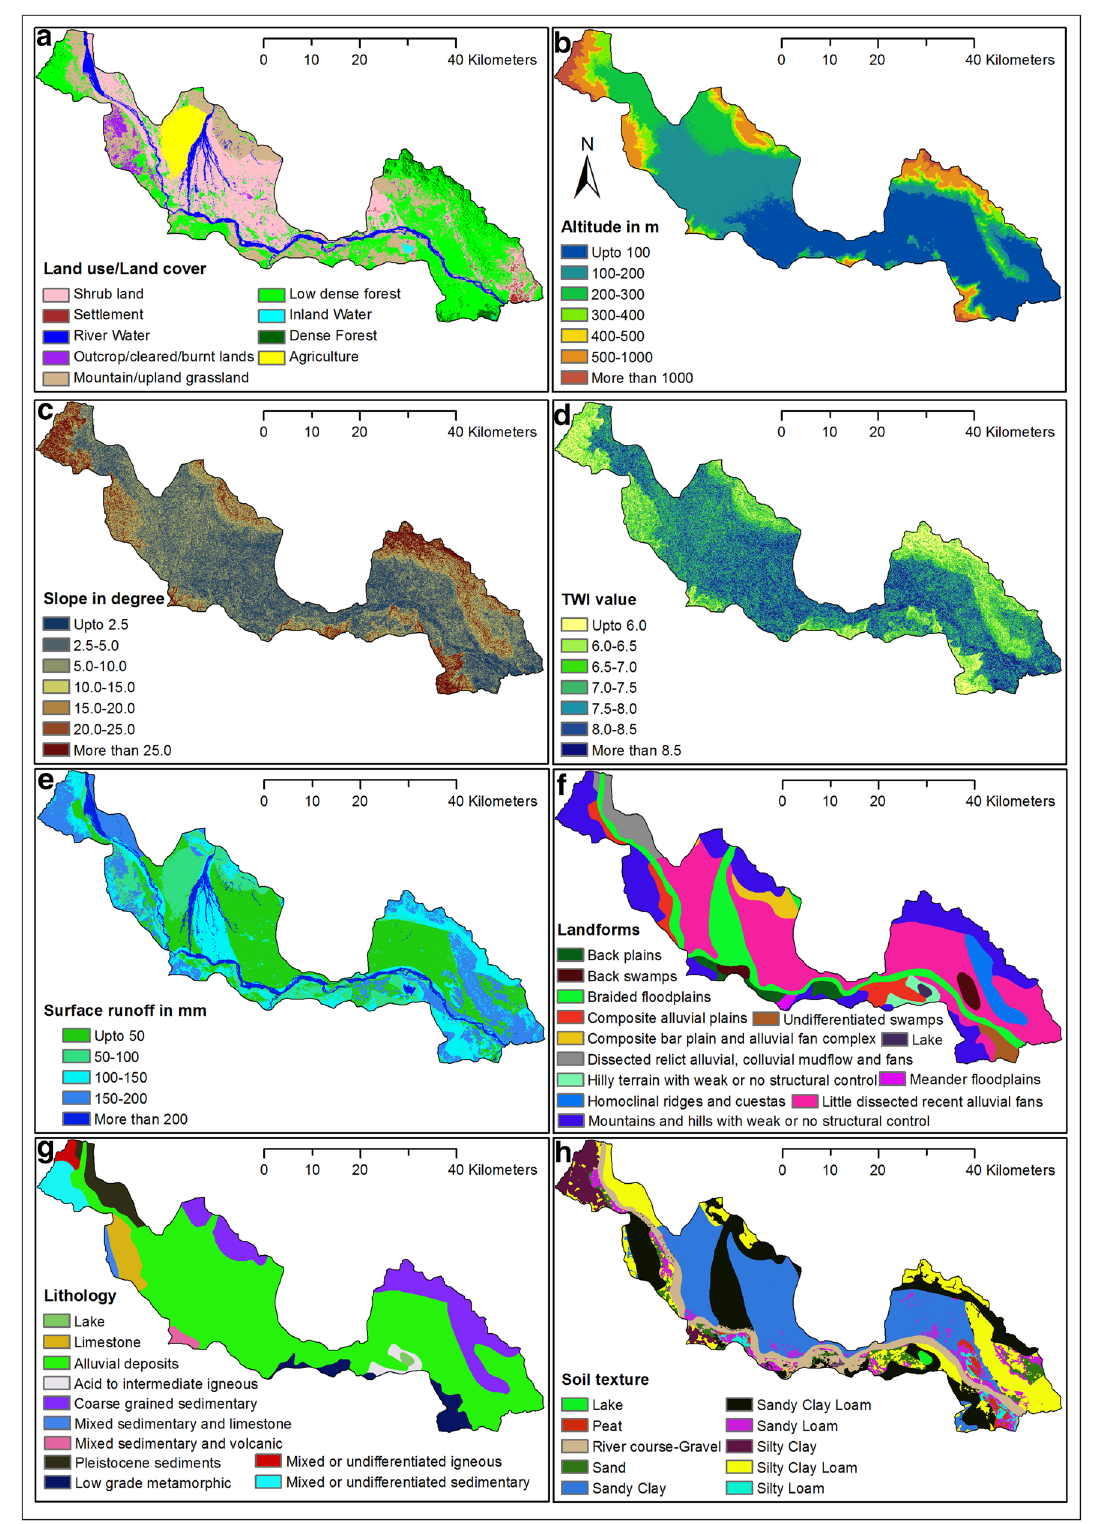
Fig. 2 Parameters used for FR modelling: ( a ) land use/land cover, ( b ) altitude, ( c ) slope, ( d ) TWI index, ( e ) surface runoff, ( f ) landforms, ( g ) lithology and ( h ) soil texture characteristics of the study